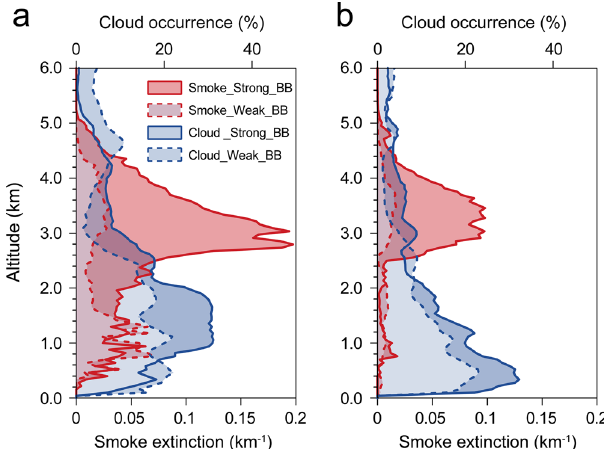
Fig. 2 Relationship between smoke and cloud occurrences measured by the CALIPSO satellite instruments. Averaged vertical pro fi les of Cloud- Aerosol Lidar and Infrared Path fi nder Satellite Observation (CALIPSO) smoke extinction and cloud occurrence in the 3 years with the highest (indicated as “ Strong_BB ” ) and the lowest (indicated as “ Weak_BB ” ) smoke aloft during 2007 – 2015 for a Baibu Bay (2010, 2012, 2014 as high years compared to 2008, 2009, 2011) and b the Taiwan Strait (2007, 2010, 2015 as high years compared to 2008, 2012, 2013). Region de fi nitions are given in Fig. 1a. The highest and the lowest 3 years were classi fi ed according to the column smoke extinction between 2 and 5 km, excluding years with inconsistent aerosol optical depth and extremely high smoke aerosol concentrations above the